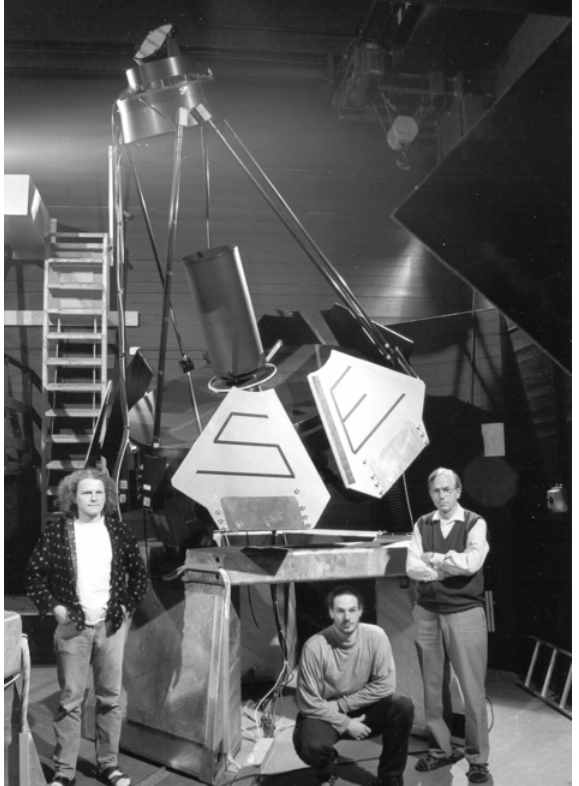
Fig. 4. The South-East telescope, in tilted position. In the centre of the figure are the 1.8 m primary and its light ba(cid:130)e. Six struts carry at their upper ends the secondary mirror cell and laser beam guiding mirror BGM 5. The primary is surrounded by six covers which can enclose the primary in less than 10 s. By separately moving the corners of the primary mirror cell up and down with the spindle drives, the specified tilt and azimuth angles are reached. The tiltable structure of the telescope rests on a massive hexagonal table. Persons in front of the table are (from left to right ) G. Baumgarten, D. Wagner, and U.